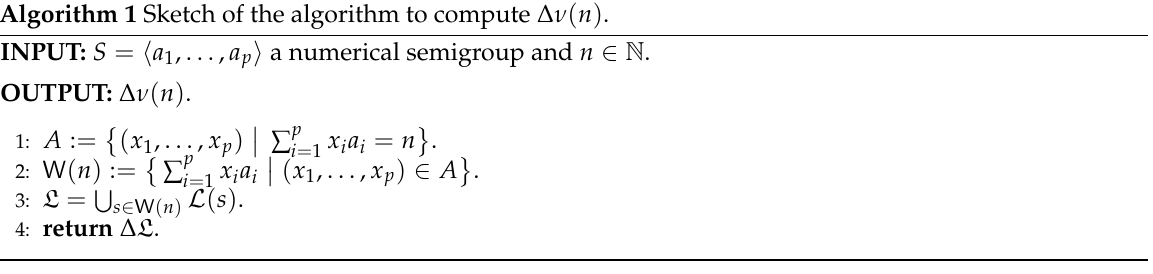
Algorithm 1 Sketch of the algorithm to compute ∆ ν ( n )